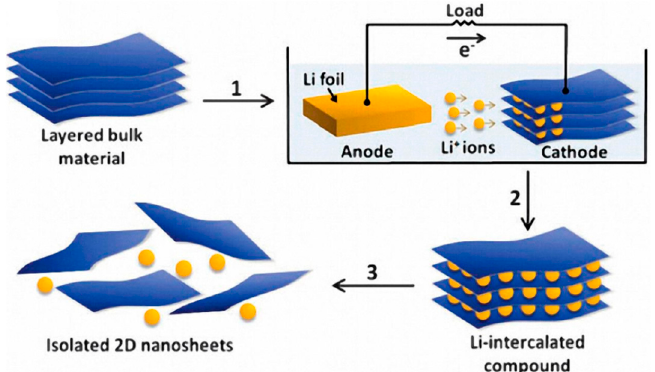
Figure 59. Schematic illustration of the electrochemical Li intercalation-assisted liquid exfoliation method for preparation of single- or few-layer transition metal dichalcogenide (TMD) nanosheets